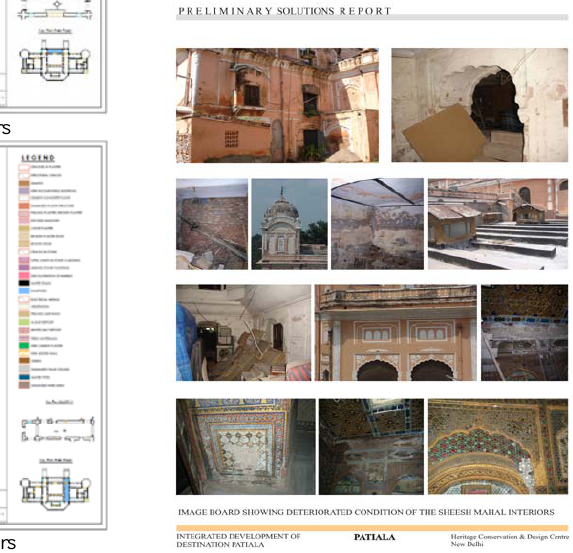
Figure 9: Condition mapping of chambers